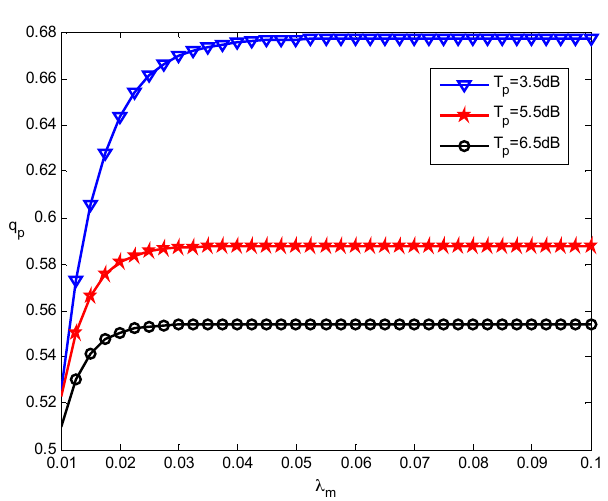
Figure 3. Effect of picocell density on the pico-tier coverage performance. Sensors 2016 , 16 , 1854